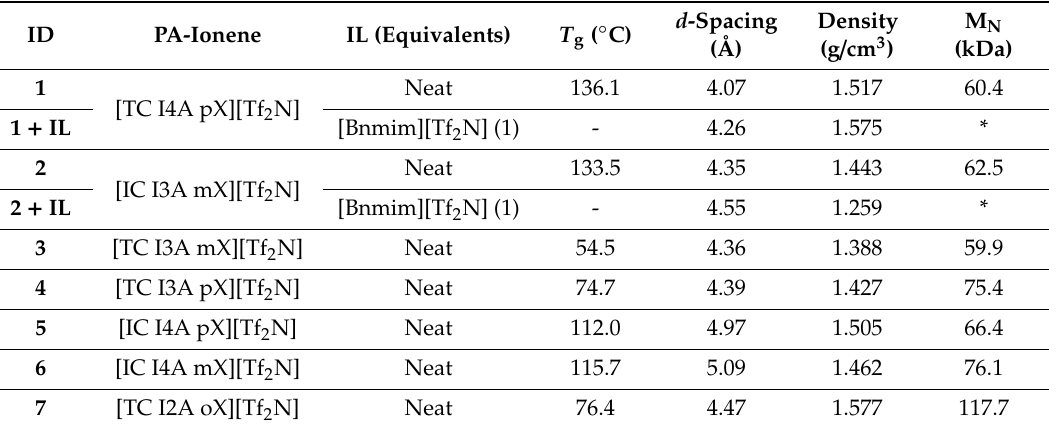
Table 2. Summary of thermal, structural, and molecular weight data for